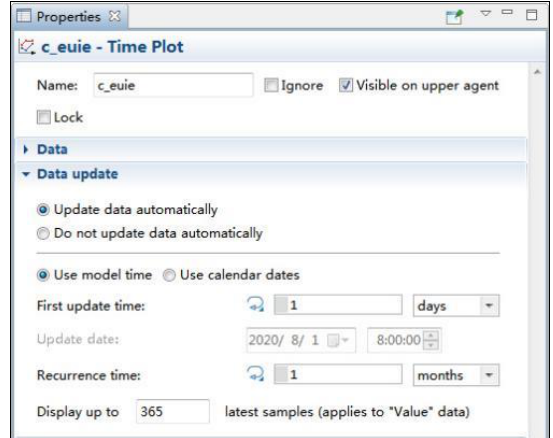
Figure 9. Simulation output of the energy consumption under the climate sub-model on the main panel.